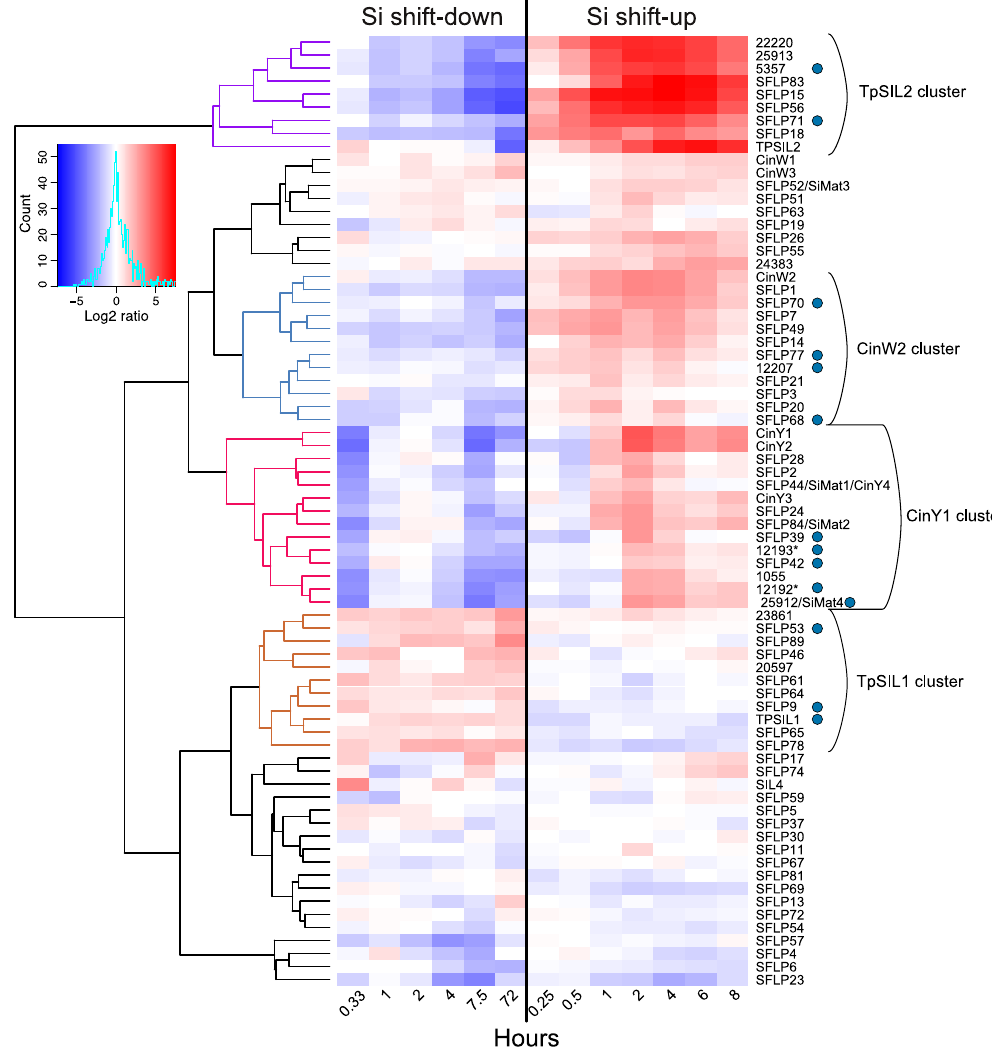
Figure 4. Cluster analysis of Silaffin-like protein ( SFLP ) expression during Si shift-up and Si shift-down. Heat map representing log2-transformed fold change in expression for the indicated time points of the two experiments. The colour key and histogram is shown to the left. All differentially expressed SFLP s and ten new KXXK motif-containing proteins were included and clustered, discussed clusters are highlighted in colour. SFLP s are annotated according to Scheffel et al . 41 . Numbers indicate JGI Thaps3 gene IDs. Blue circles indicate the presence of PT repeats. Gene IDs 12192 and 12193 (indicated by asterisks) are likely parts of the same